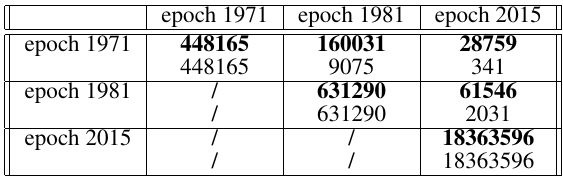
Table 2. Number of extracted tie-points with Ours (in bold), and with SIFT intra − inter. µ [m] σ [m]